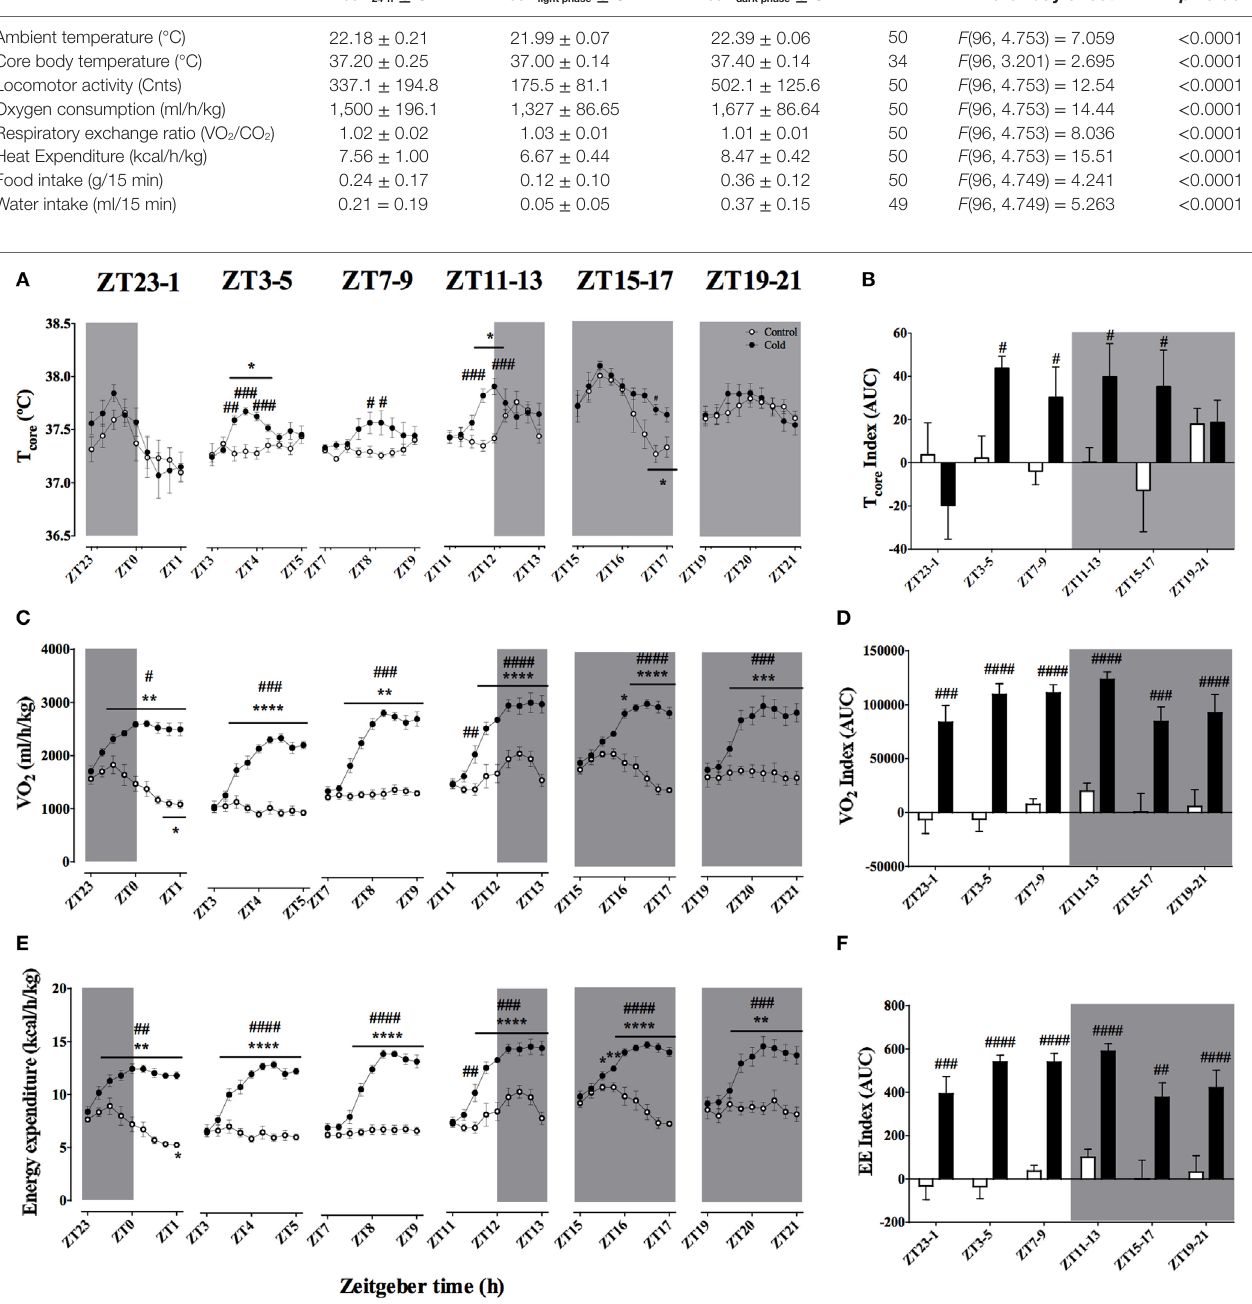
FigUre 3 | Effect of time­of­day on body temperature (a,B) , VO 2 (c,D) , and energy expenditure (e,F) changes induced by environmental cooling. Results are presented as averages of 15 min bins during 2 h of environmental cooling (a,c,e) and as the area under the curve (AUC) (B,D,F) calculated as the net change from the basal levels before cold exposure. Light phase began at Zeitgeber Time 0 (ZT0) and dark phase (shaded areas) began on ZT12. Results are presented as mean ± SEM. * indicates differences between the first and the other time­points within the control or the cold­exposed group, p < 0.05. # indicates differences between control and cold conditions, p < 0.05. n = 5–11/group/ZT.